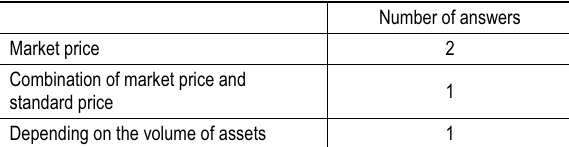
Table 7. Answer to the question: criteria in determining transfer prices